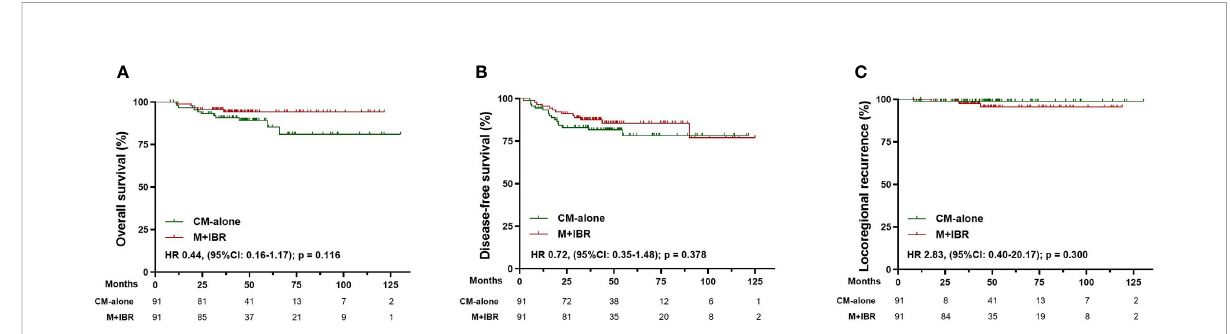
FIGURE 5 Survival analysis in the matched cohort of patients receiving conventional mastectomy alone (n=91) and mastectomy plus immediate breast reconstruction (n=91). (A) Kaplan-Meier curves for overall survival analysis in patients of different surgical groups. (B) Kaplan-Meier curves for disease-free survival analysis in patients of different surgical groups. (C) Kaplan-Meier curves for locoregional recurrence analysis in patients of different surgical groups. CM-alone, conventional mastectomy alone; M+IBR, mastectomy plus immediate breast reconstruction; HR, Hazard ratio; 95% CI, 95% con fi dence